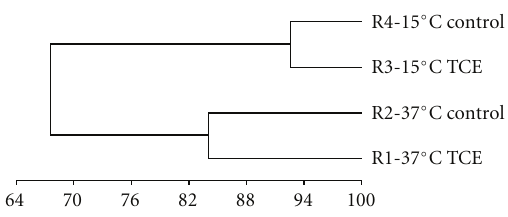
Figure 2: Bacterial UPGMA cluster analysis of 16S rDNA frag- ments generated from DGGE banding profiles. Percent similarity calculated by (1 − Sorensons (Bray-Curtis) distance measurement) ∗ 100. R1: 37 ◦ C TCE-supplemented; R2: 37 ◦ C control; R3: 15 ◦ C TCE-supplemented; R4: 15 ◦ C